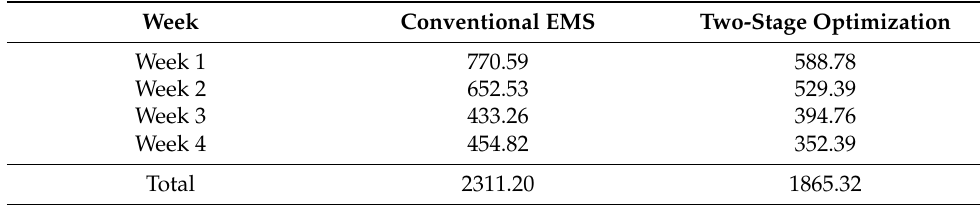
Table 7. Costs (EUR) generated by the connection of the charging station to the